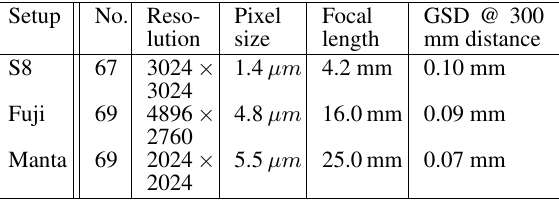
Table 1. Settings for photogrammetry.